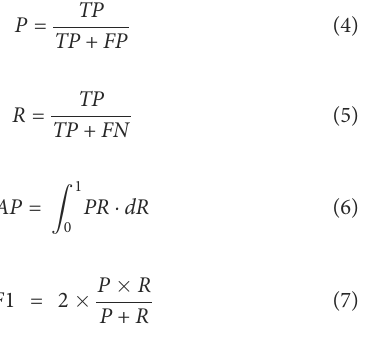
algorithm, which indicates the number of frames per second